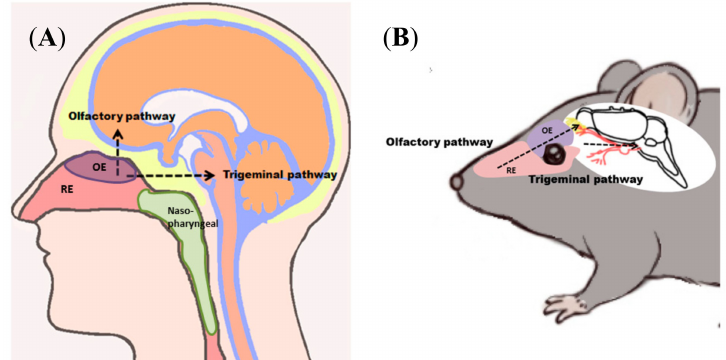
Figure 1. Nose-to-brain (N2B) delivery allows application of drugs at the roof of the nasal cavity, which are transported to the central nervous system (CNS) of humans ( A ) and rodents ( B ). N2B transport can either be mediated via the olfactory or the trigeminal pathway. Drugs passing along the olfactory pathway target the olfactory bulb, whereas drugs transported via the trigeminal pathway are delivered predominantly to the brain stem. Abbreviations: OE: olfactory epithelium/mucosa; RE: respiratory